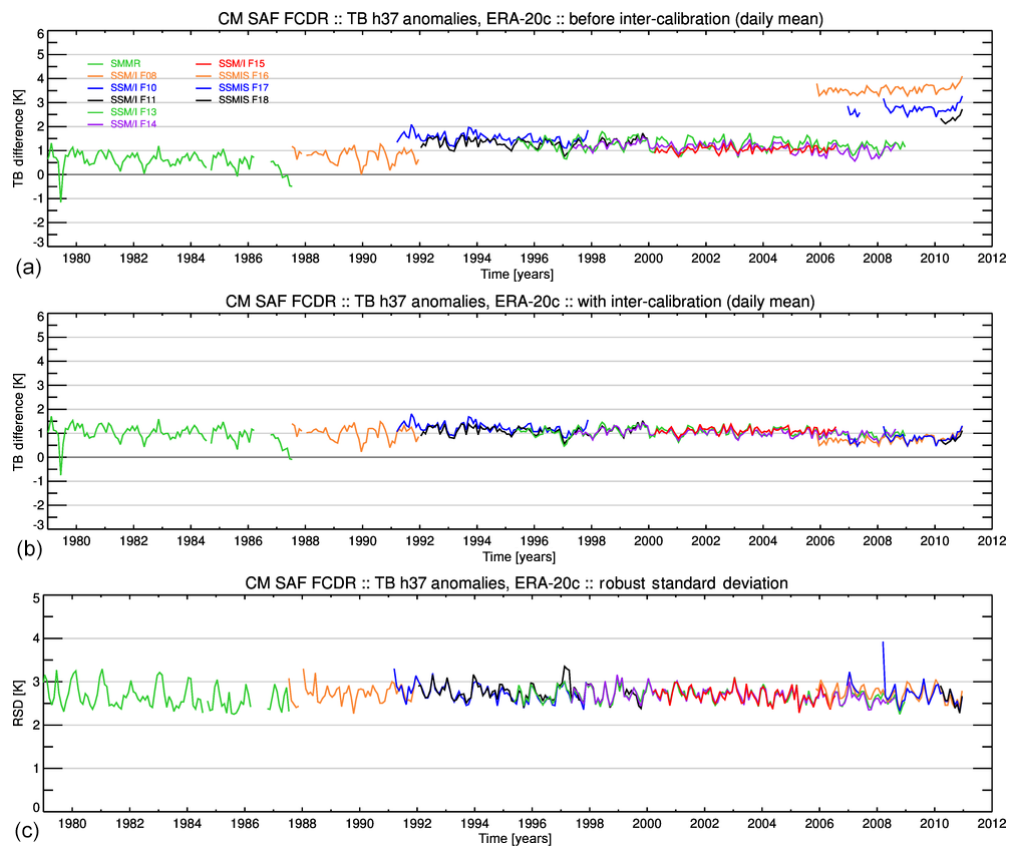
Figure 10. Time series of global monthly mean T B differences for the 37GHz, h-pol channel between the CM SAF FCDR and ERA-20C without inter-calibration (a) and with inter-calibration (b) and the RSD of the inter-calibrated data record and ERA-20C (c) . Colours for the instruments are in parentheses: SMMR (green), F08 (orange), F10 (blue), F11 (black), F13 (green), F14 (violet), F15 (red), F16 (orange), F17 (blue), and F18